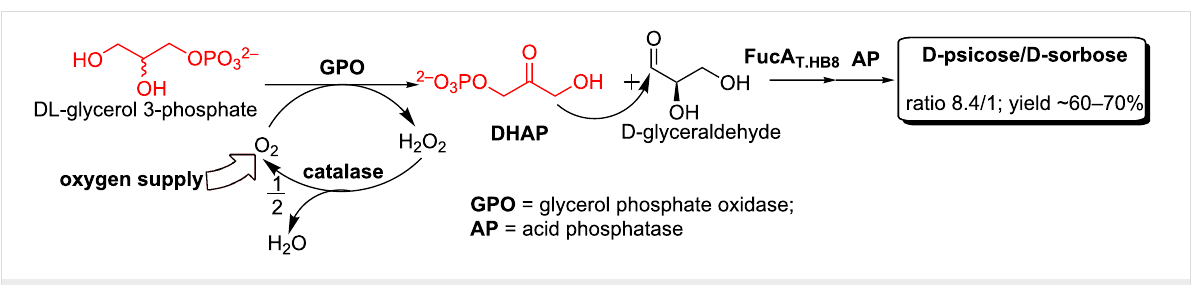
Scheme 3: Enzymatic synthesis of D-psicose using aldolase FucA.